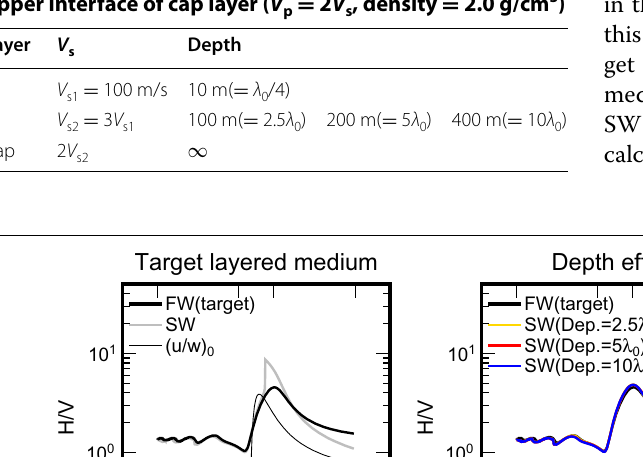
Table 2 Cap‑layered media with different depths of the upper interface of cap layer ( V